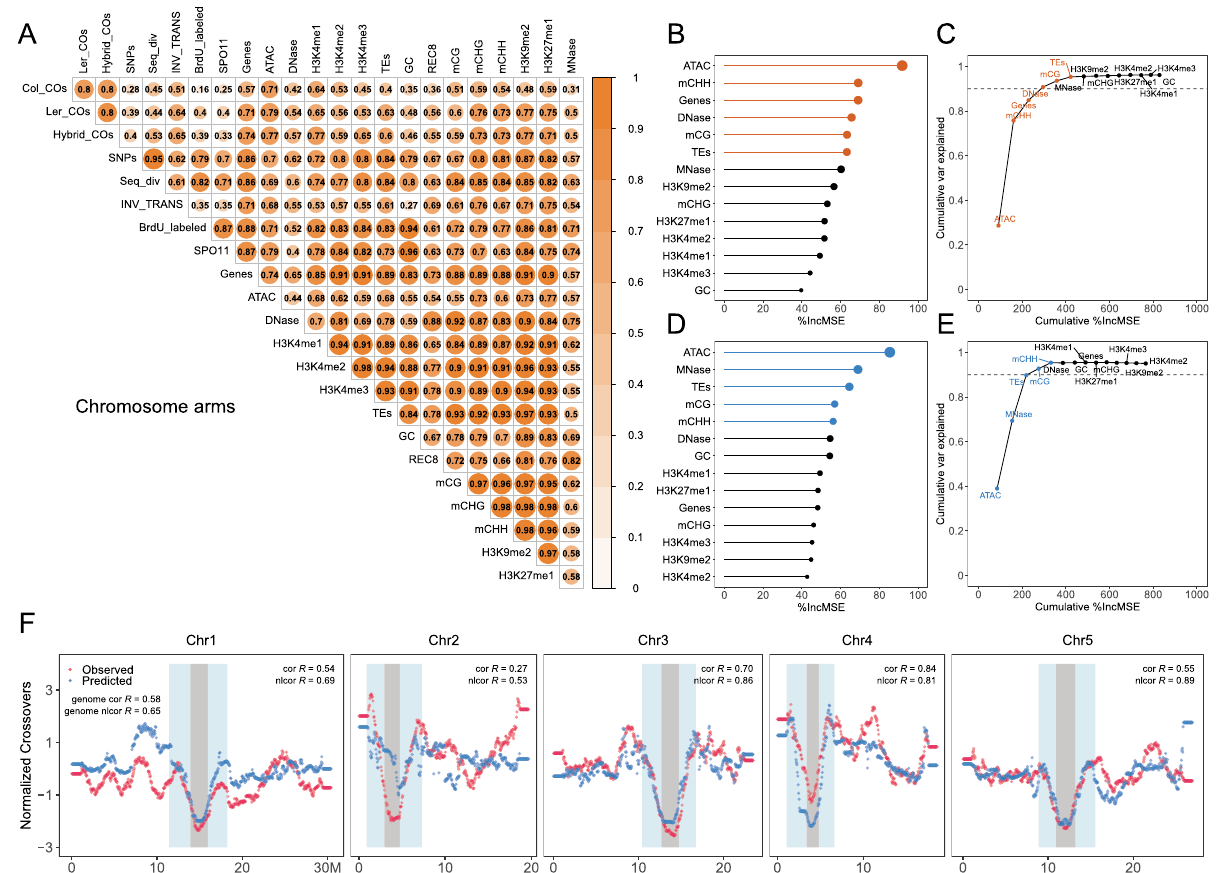
Fig. 4 Association and prediction of CO distribution with genomic and epigenomic features. A The non-linear correlation matrices show the comparison of pairwise features along chromosome arms, with differences in colour and size according to the correlation scale. Col_COs, Ler_COs and Hybrid_COs (CO landscapes in Col, L er , and F2 hybrids), SNPs (SNPs density between Col and L er ), Seq_div (sequence diversity in the population of 2029 Arabidopsis accessions), INV_TRANS (inversions and translocations between Col and L er ), BrdU_labelled (origins of DNA replication, log 2 (BrdU/gDNA)), SPO11 (SPO11-1-oligos, log 2 (oligos/gDNA)), Genes, TEs and GC (gene, TE and GC density), ATAC and DNase (chromatin accessibility, ATAC-seq and DNase- seq, log 2 (Tn5/gDNA) and log 2 (DNase/gDNA)), H3K4me1/2/3, H3K9me2, H3K27me1 (euchromatin, heterochromatin, and Polycomb histone marks, ChIP-seq, log 2 (ChIP/input)), REC8 (cohesin, ChIP-seq, log 2 (ChIP/input)), mCG, mCHG and mCHH (DNA methylation in CG, CHG, and CHH contexts, proportion methylated cytosine), MNase (nucleosome occupancy, MNase-seq, log 2 (MNase/gDNA)). The importance of each of the 14 features for explaining variation in CO distribution at the chromosome-arm ( B ) and genome scale ( D ), respectively. The size of points corresponds to the importance. The cumulated proportion of variation that can be explained with the features at the chromosome-arm ( C ) and genome scale ( E ), respectively. The top six and fi ve most important features, for which the cumulative proportion of variation that can be explained reaches the plateau, are coloured separately. F The chromosomal distribution of observed and predicted COs. The CO pro fi les of individual chromosomes were predicted using pro fi les of the top fi ve most important features from the other four chromosomes. The Spearman ’ s and non-linear correlation coef fi cients between the predicted and observed CO distributions for each chromosome and the whole genome are indicated, respectively. Source Data are provided as a Source Data fi